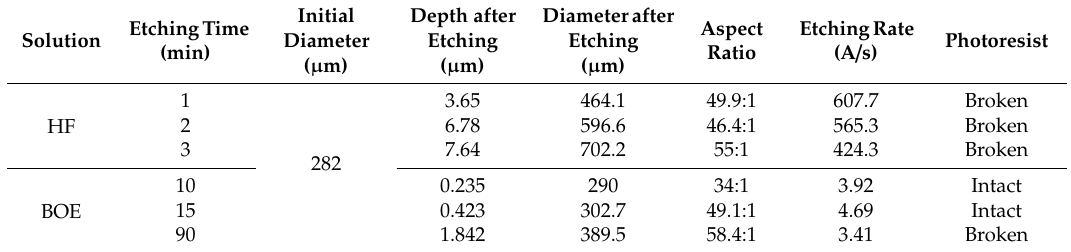
Table 5. Wet etching with the protection of 8- µ m-thick AZ4620 photoresist (Scheme I).